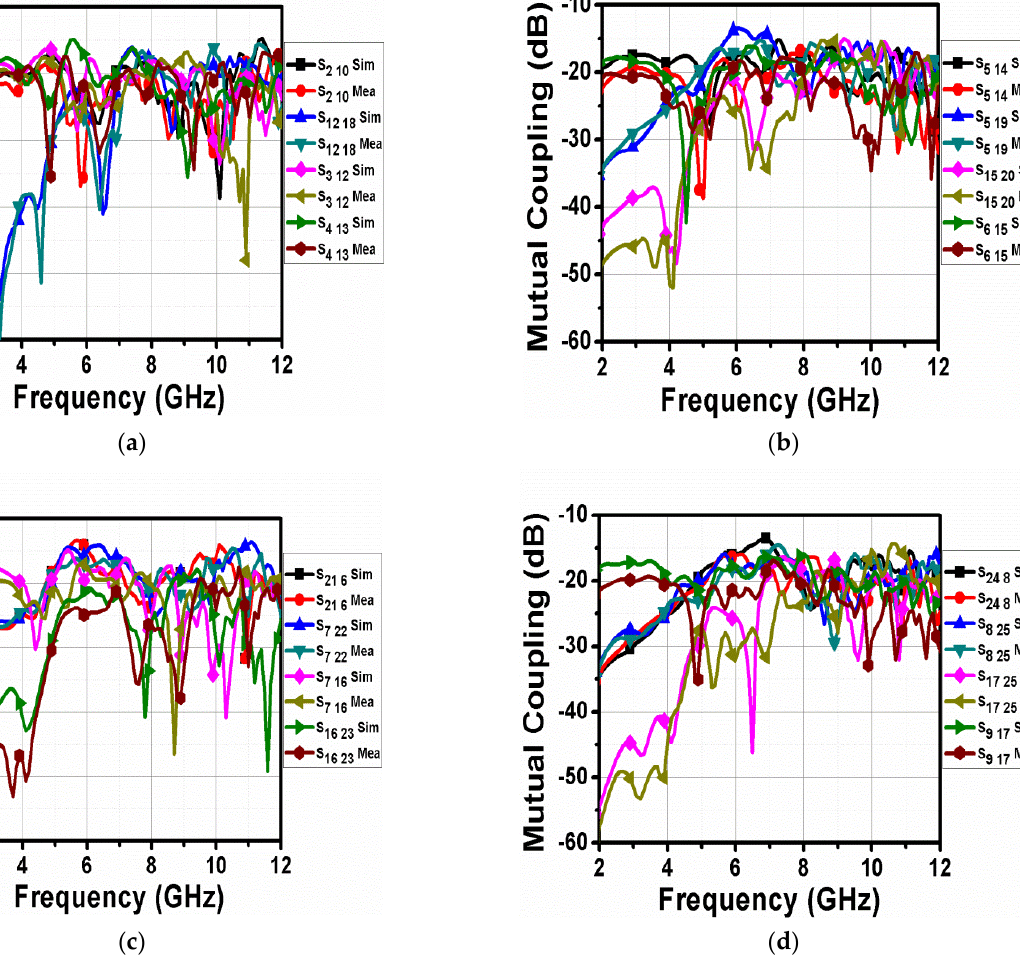
Figure 23. Mutual coupling between non-identical communication antennas. ( a ) S 2 10 , S 12 18, S 3 12 , and